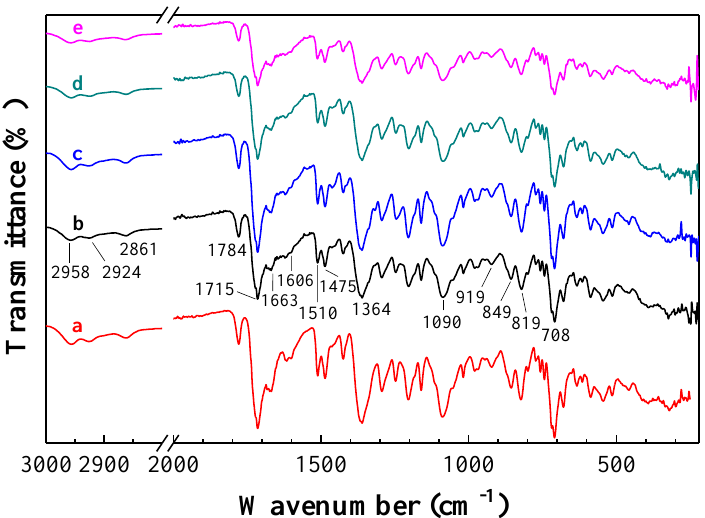
Figure 3. ATR-FTIR spectra of ( a ) a pristine Matrimid matrix and of Matrimid MMMs doped at 2 wt % with different fillers: ( b ) as-prepared g-C 3 N 4 , ( c ) protonated g-C 3 N 4 , ( d ) oxygen plasma-treated g-C 3 N 4 , and ( e ) hydrazinated g-C 3 N 4 .